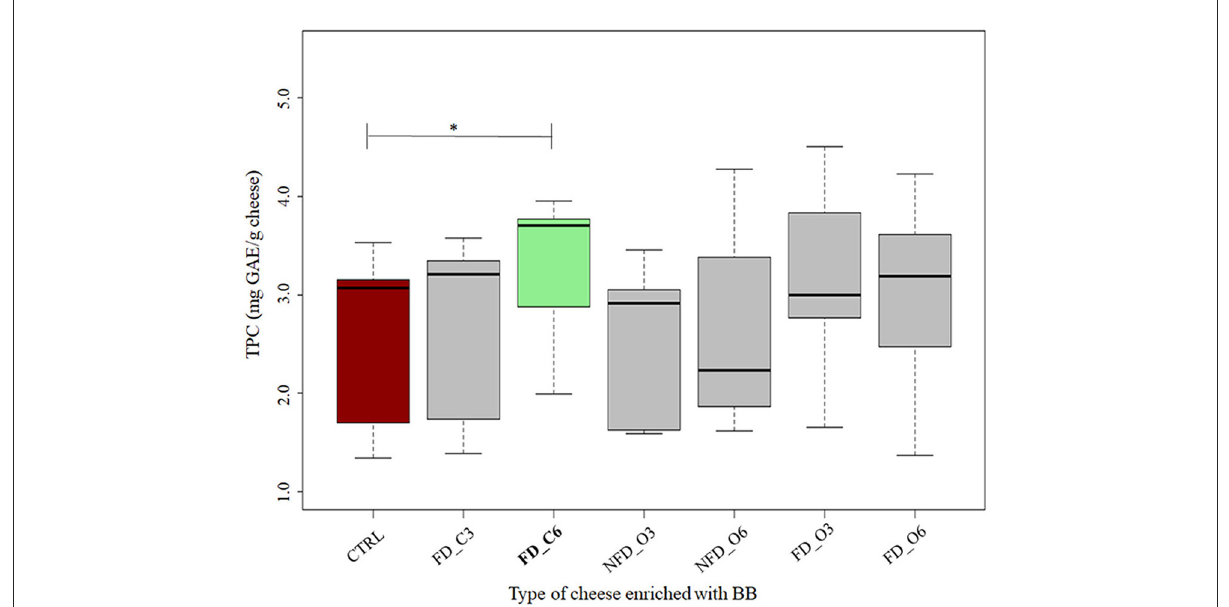
FIGURE3 Total Polyphenol Content (TPC) in cheeses added with blackcurrant (BB) expressed in mg GAE/g cheese. CTRL: controls in red; NFD_C3: 0.3% not freeze-dried conventional BB cheeses; NFD_C6: 0.6% not freeze-dried conventional BB cheeses; FD_C3: 0.3% freeze-dried conventional BB cheeses; FD_C6: 0.6% freeze-dried conventional BB cheeses; FD_O3: 0.3% freeze-dried organic BB cheeses; FD_O6 0.6% freeze-dried organic BB cheeses; NFD_O3: 0.3% not freeze-dried organic BB cheeses; NFD_O6: 0.6% not freeze-dried organic BB cheeses. The thick horizontal black bars indicate the medians; the boxes indicate the range between the first (25th percentile) and the third quartile (75th percentile). The whiskers represent extreme values. Significant differences between CTRL and enriched cheeses are indicated by an asterisk (*: p -values < 0.05). n = 3 for enriched cheeses; n = 6 for CTRL cheeses. The TPC boxes significantly different are in green color.